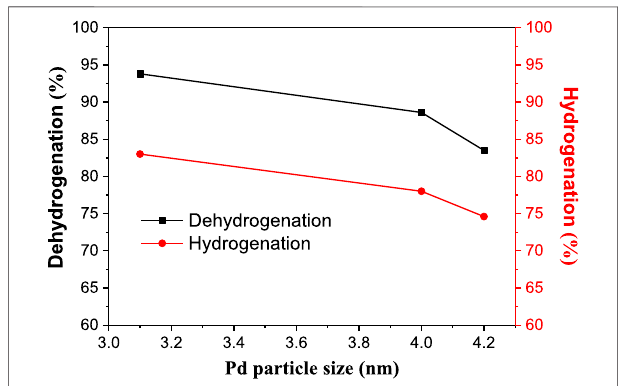
FIGURE 4 | The correlation between the Pd particle size and dehydrogenation and hydrogenation abilities of catalysts.